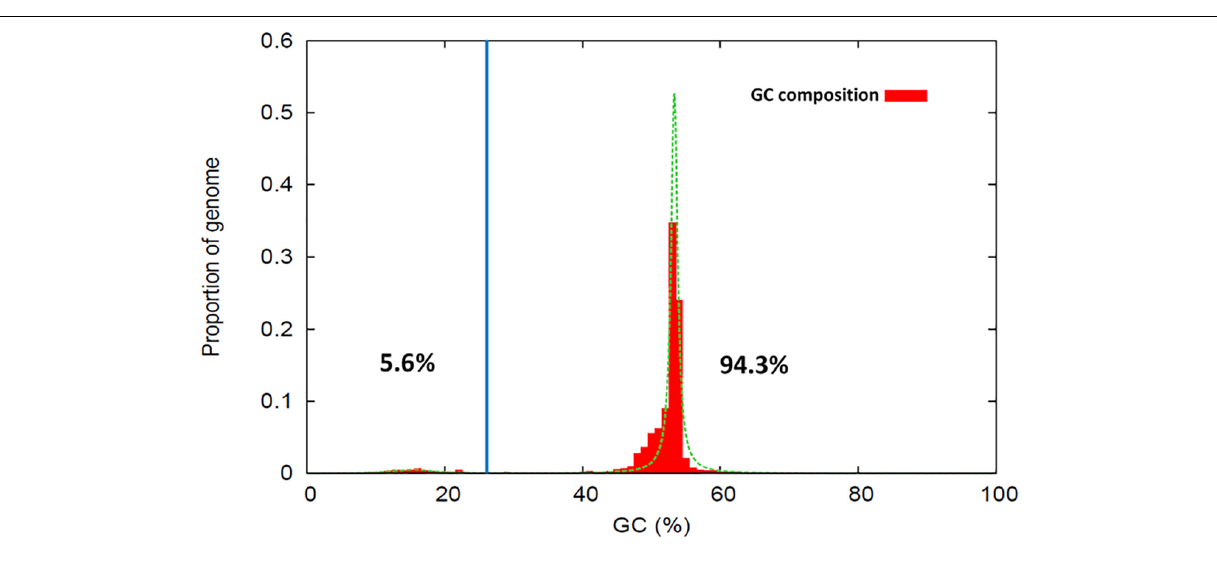
FIGURE 3 | Proportion of sequence regions with distinctive GC-content profiles within the Nalanthamala psidii MA3 genome. The percentage values shown indicate the proportion of the genome classified within the AT-rich (Left) and GC-equilibrated (Right) peak